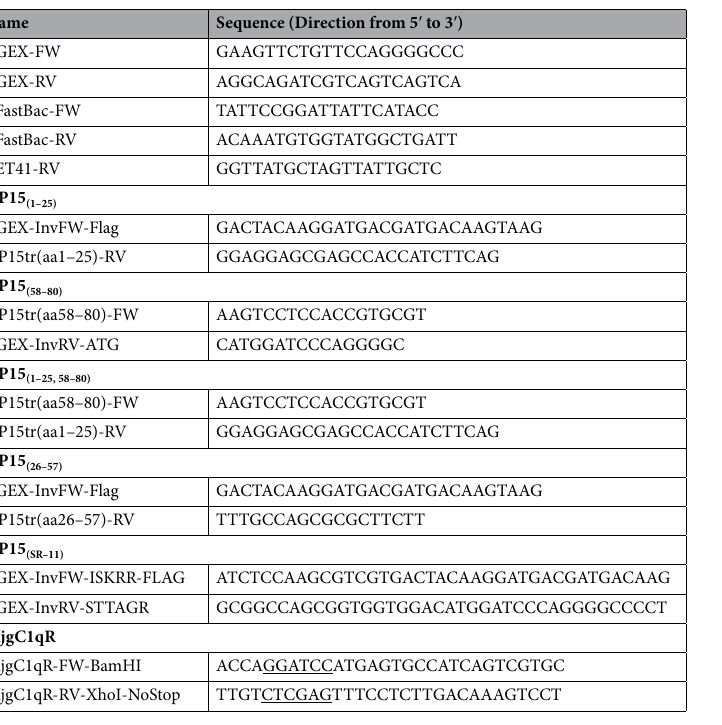
Table 2. Primers used in this